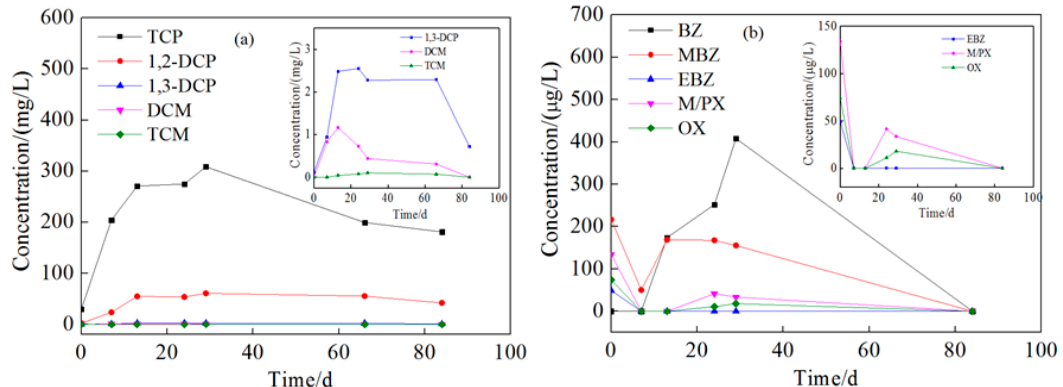
Figure 8. Concentration change of pollutants at shallow injection well (1,2,3-trichloropropane, 1,2-dichloropropane, 1,3-dichloropropane, dichloromethane, trichloromethane, benzene, methylbenzene, ethylbenzene, m-xylene/p-xylene, and o-xylene are abbreviated as TCP, 1,2-DCP, 1,3-DCP, DCM, TCM, BZ, MBZ, EBZ, M/PX, and OX, respectively). Ordinate: ( a ) The concentration of chlorinated hydrocarbons; ( b ) the concentration of benzene, toluene, ethylbenzene, and xylene (BTEX). Inset: ( a ) Amplified concentration change curves of 1,3-DCP, DCM, and TCM; ( b ) amplified concentration change curves of EBZ M/PX, and OX.